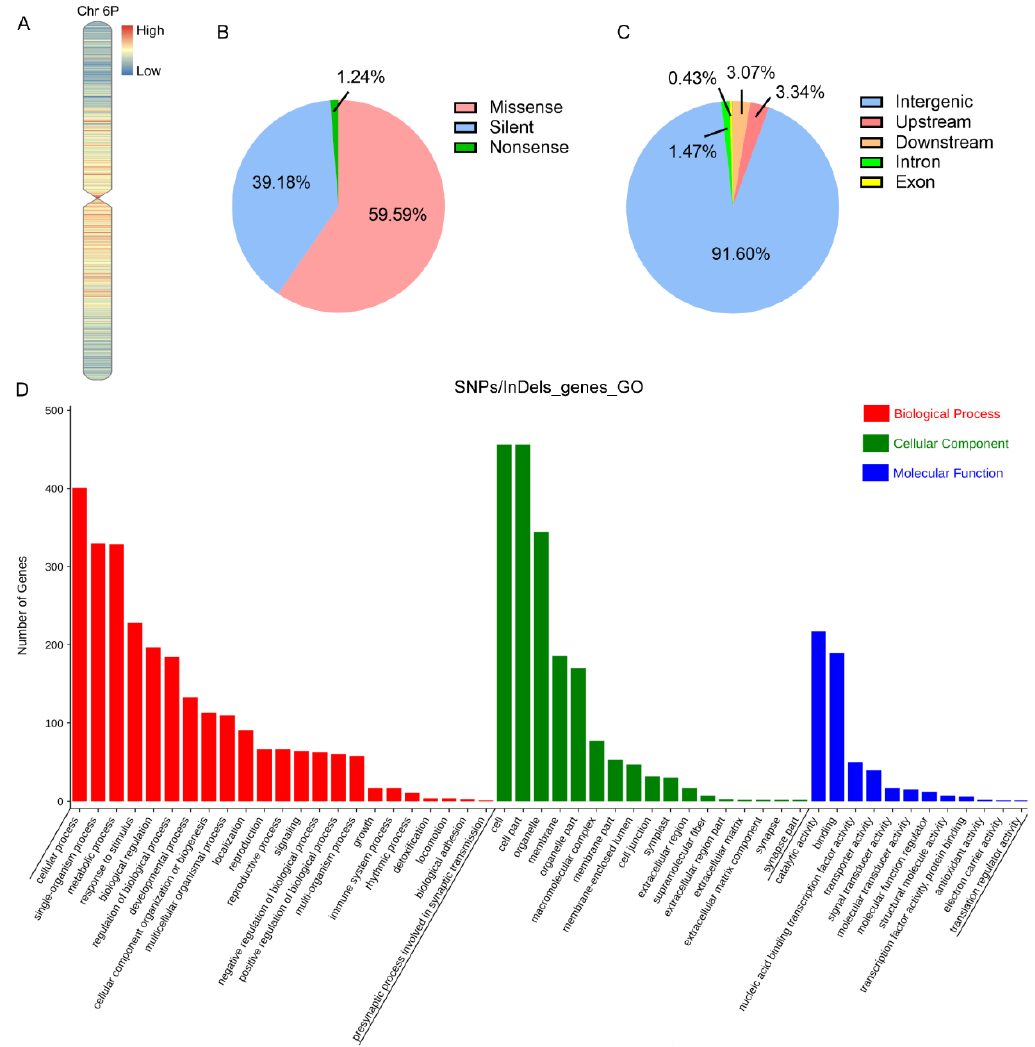
Figure 3. Genome resequencing analysis of 5113 and II-30-5. ( A ) Distribution of the SNPs and InDels in the 6P chromosomes of 5113 and II-30-5. ( B ) Summary of the effects of SNP variations on gene function. ( C ) Pie chart representing the distribution regions of SNPs/InDels in 5113 and II-30-5 6P variant genes. ( D ) GO enrichment of the SNP/InDel variant genes between 5113 and II-30-5.